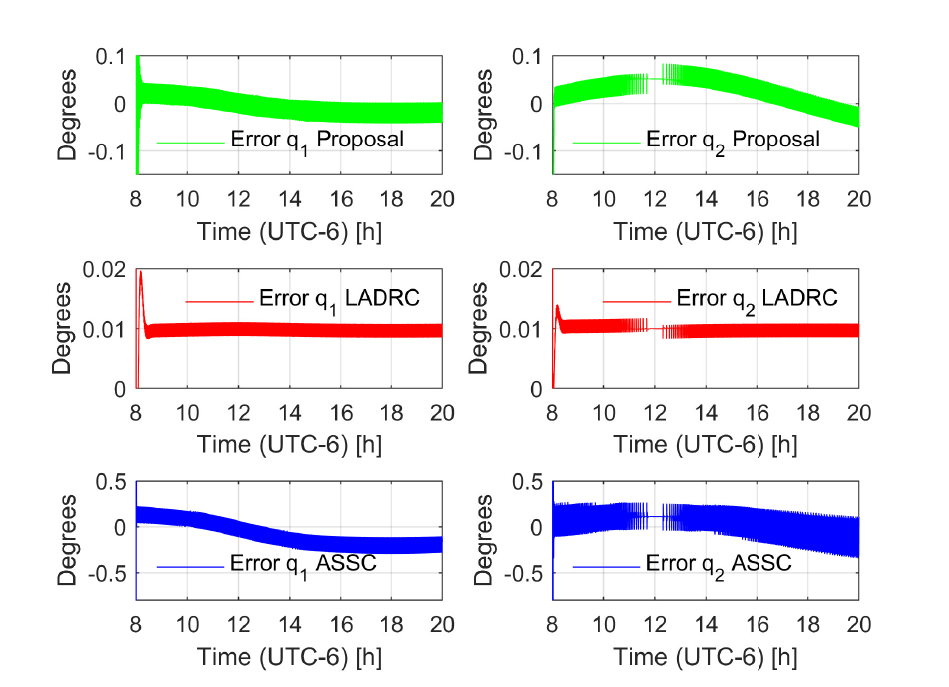
Figure 3. Tracking error behavior comparison (non-disturbed case) for azimuthal axis ( q 1 ) and elevation axis ( q 2 ). LADRC stands for linear active disturbance rejection control and ASSC for adaptive state space combination.